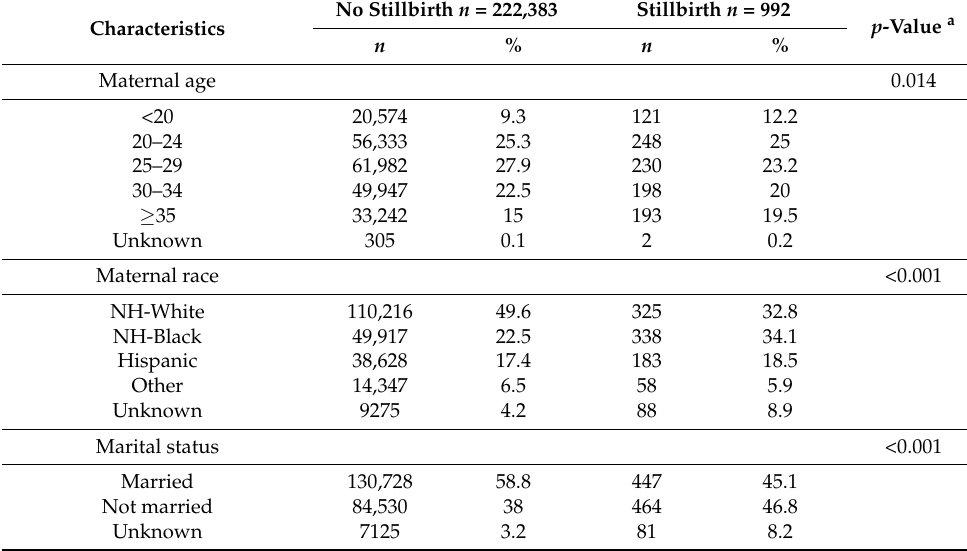
Table 1. Characteristics of pregnancies by stillbirth status from the Consortium on Safe Labor, 2002–2008 ( n =